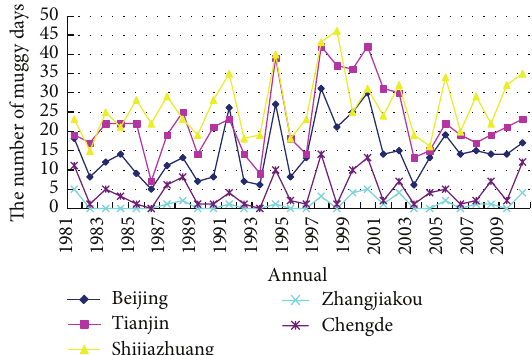
Figure 3: Interannual variations of muggy days in the five represen- tative